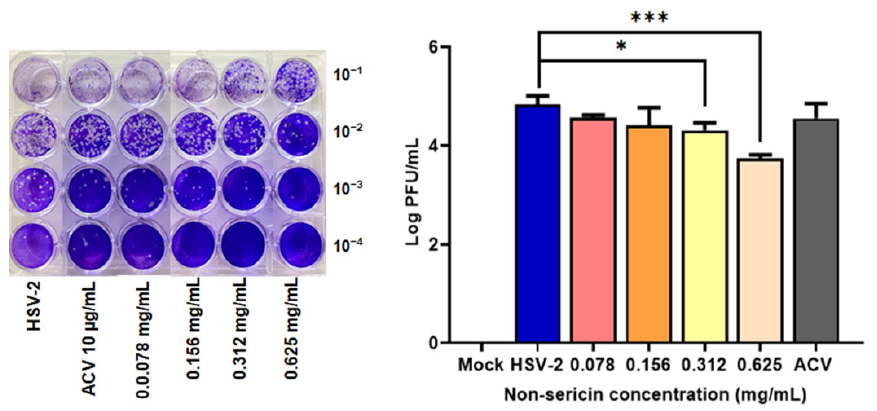
Figure 3. The inhibitory effect of non-sericin extract on infection in HeLa cells. The cells were treated with non-sericin extract during the virus attachment steps. After 48 h of infection, the viral titers in the culture supernatant were determined by plaque titration assay (* indicates p < 0.05 *** indicates p < 0.001).